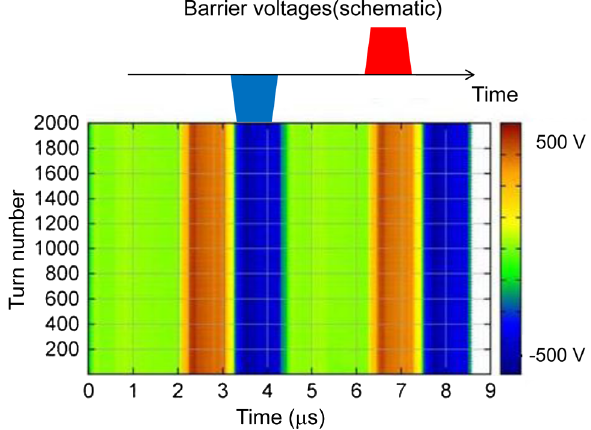
FIG. 12. Time-turn plane view of the trapped C 4 þ beam.